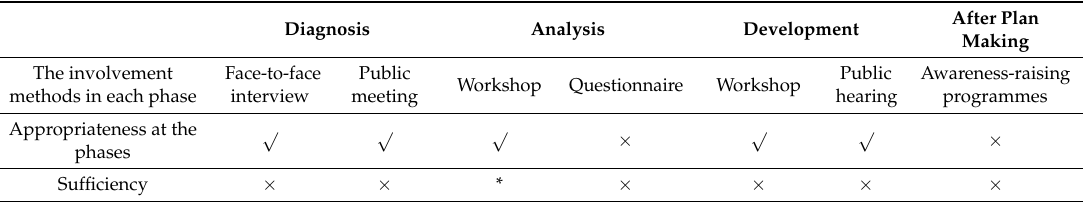
Table 2. Inappropriate and insufficient methods at each phase of the